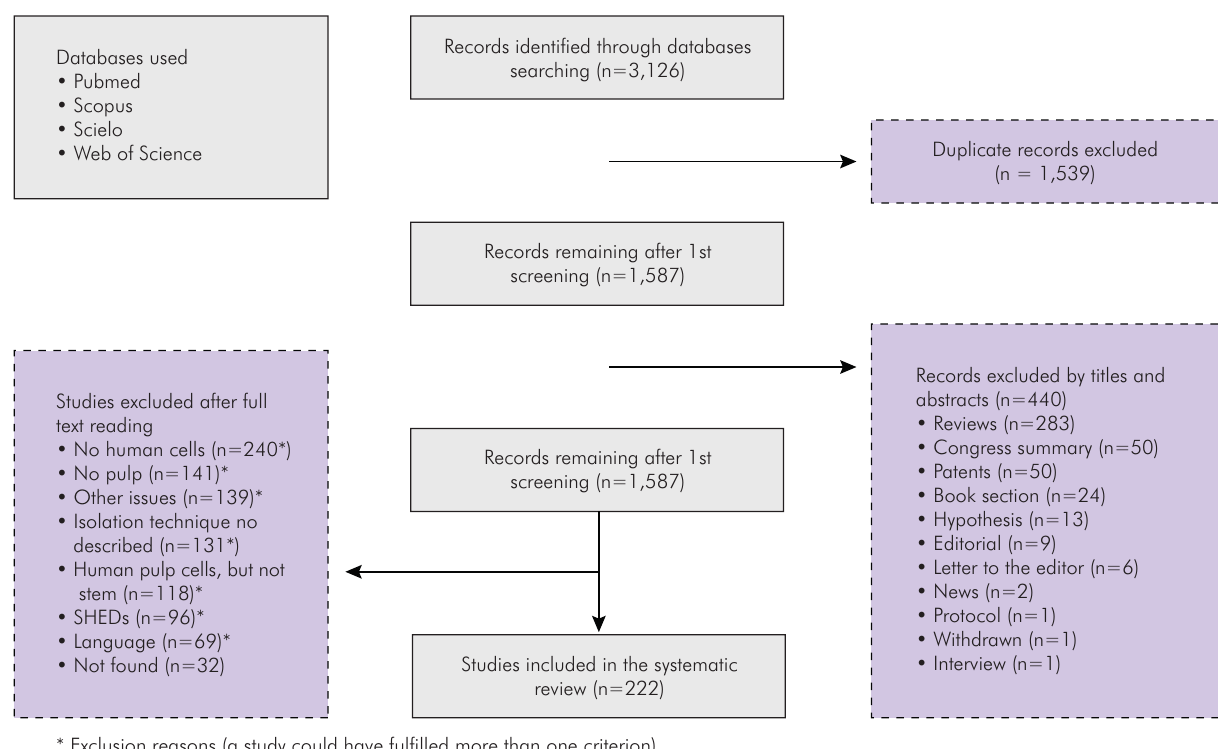
Figure 1. Flow diagram of study selection. Risk of bias considering aspects reported in the material and method